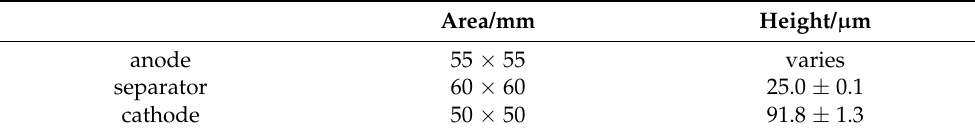
Table 4. Area and height of the used components for full cells in a pouch cell